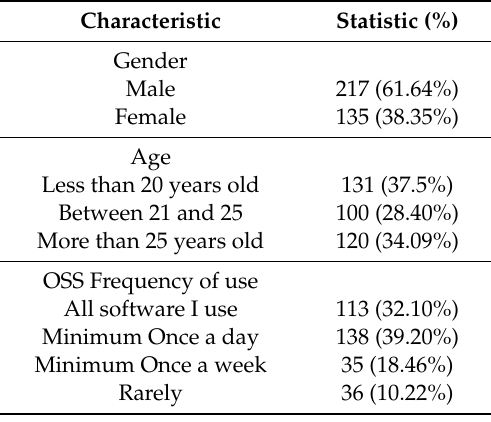
Table 1. Demographic profile of the